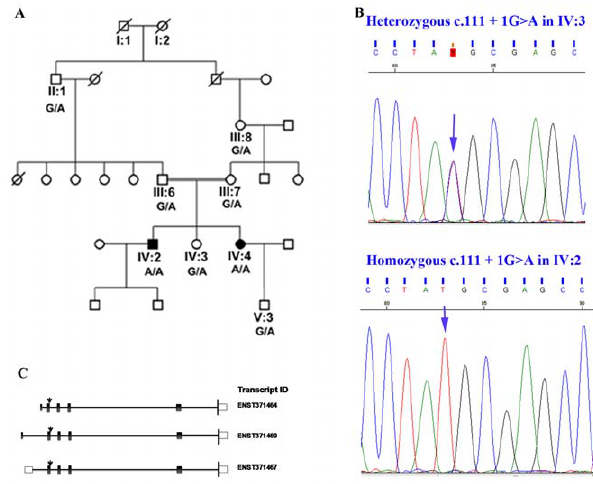
Figure 1. Genetic analysis of a family with retinal degeneration. A. Pedigree of the family with retinal degeneration. Family members that were available for study were genotyped for the RBP4 c.111 + 1 G . A mutation. B. The reverse complement sequence of the heterozygous subject IV-3 (G/A) and the homozygous subject IV-2 (A/ A) are shown. C. Protein encoding transcripts of RBP4 reported by Ensembl (http://uswest.ensembl.org). Three protein coding transcripts are reported by Ensembl . Transcripts ENST00000371464